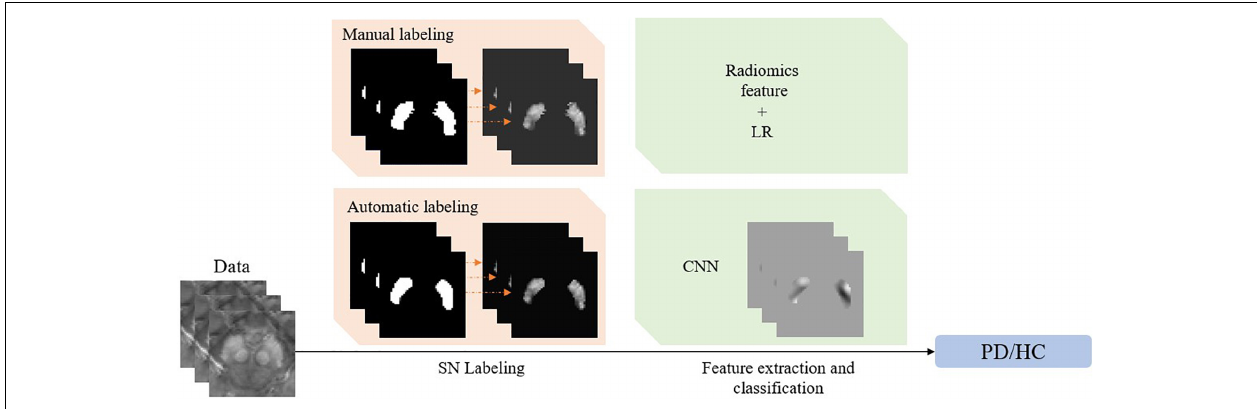
FIGURE 1 | The framework of the quantitative susceptibility mapping-based Parkinson’s disease diagnosis